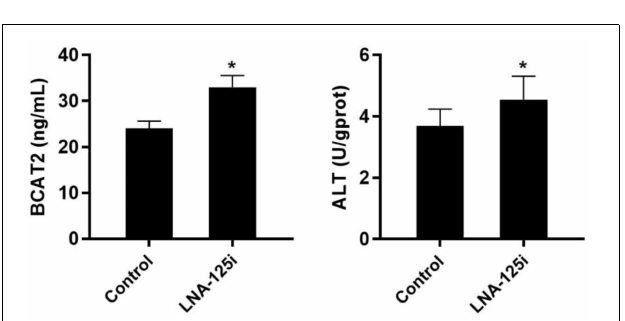
FIGURE 5 | Effect of injection with LNA-125i on the activity of BCAT2 and ALT in the skeletal muscle of Nile tilapia. Values represent the mean ± SE ( n = 9 fish, 3 fish were sampled for each tank). * p < 0.05 significantly different vs. control. ALT, alanine aminotransferase.